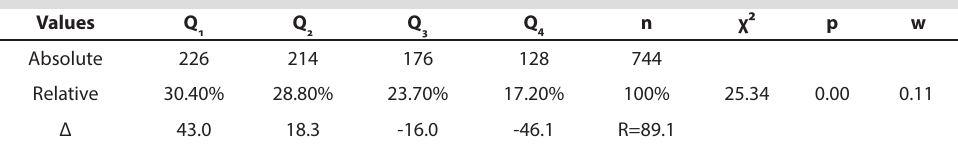
TABLE 2. The Influence of the RAE in the Entire Research Group of Hockey Players